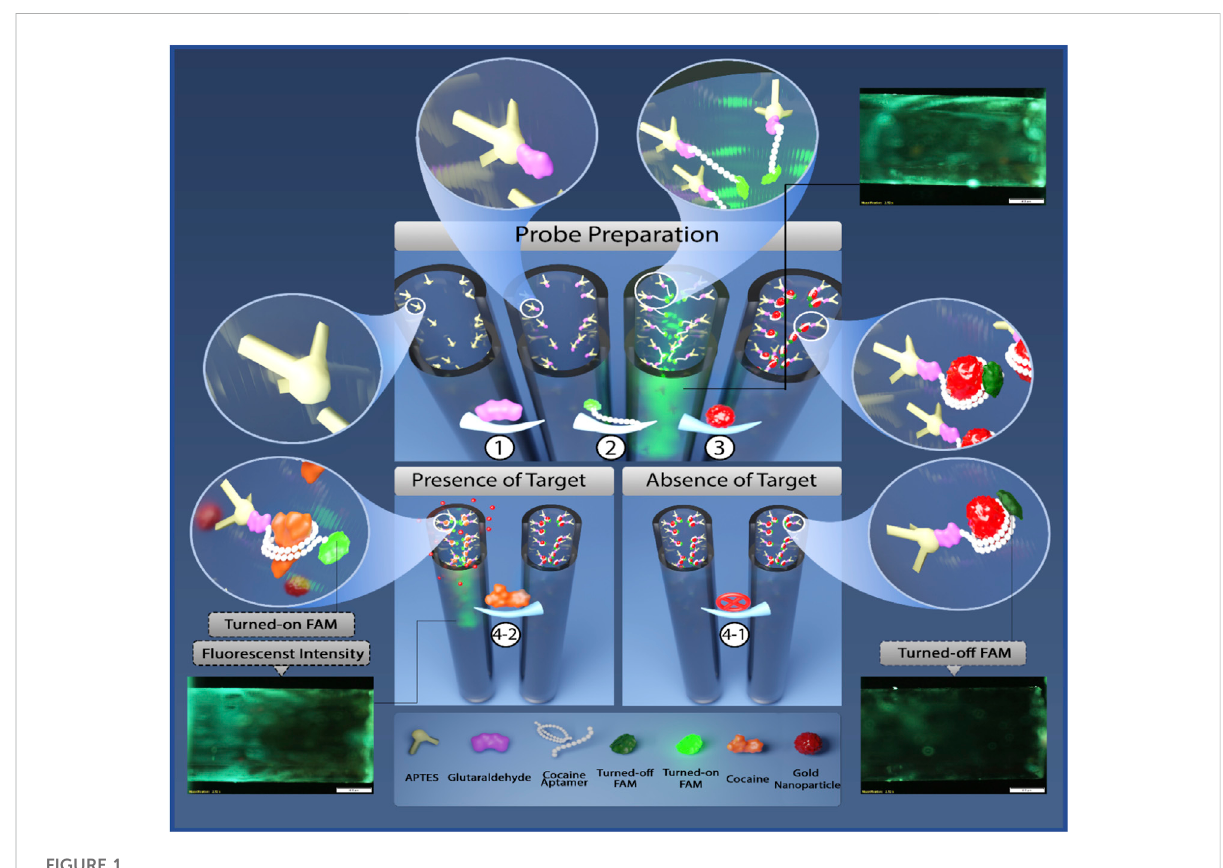
The schematic illustration of the designed aptasensor for the cocaine